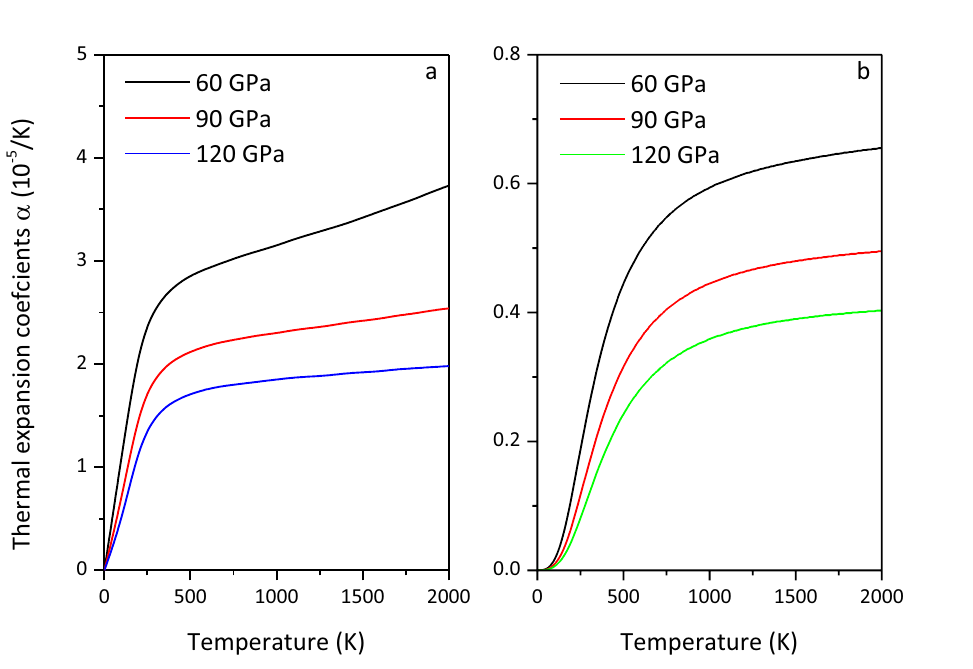
Figure 14. Thermal expansion coefficient α of MgCO 3 - C 2 /m ( a ) and Mg 2 CO 4 - P 2 1 /c ( b